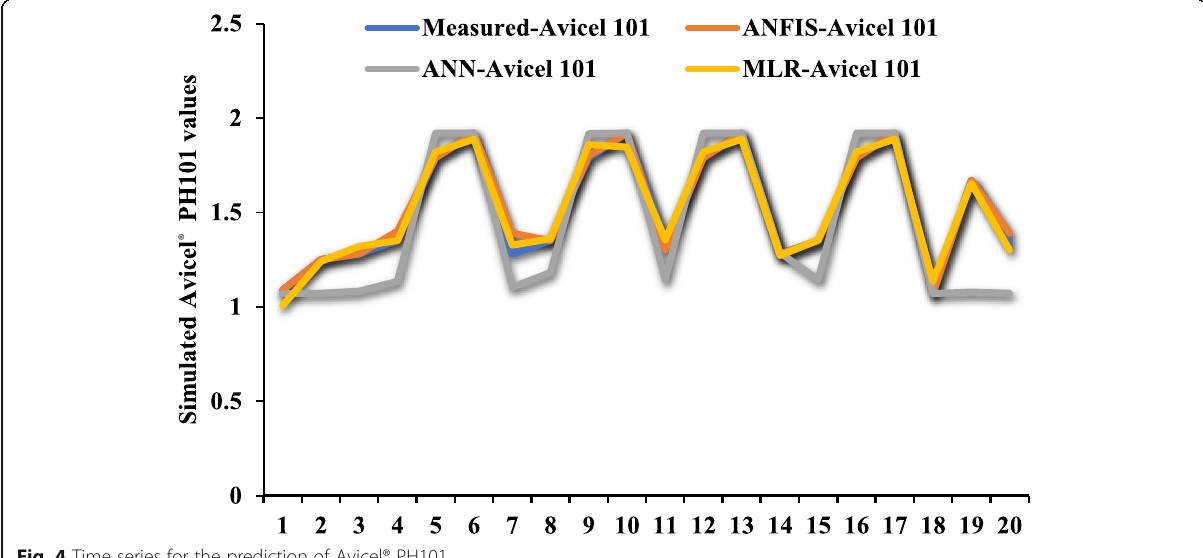
Fig. 4 Time series for the prediction of Avicel®